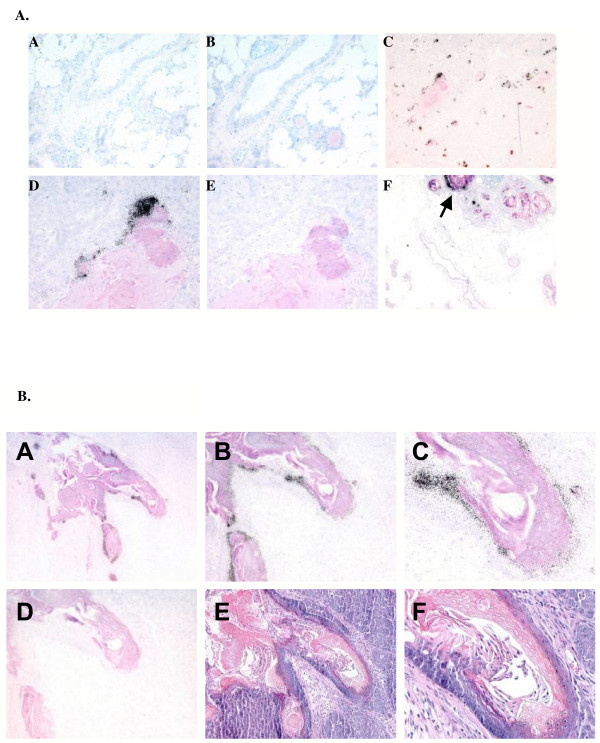
A Strong focal expression of mouse S100A7/psoriasin RNA in mammary gland tumors compared to little expression in matched normal mammary gland tissue using in situ hybridization Sections from formalin fixed paraffin-embedded mammary tissue samples matched to the frozen tissue from which RNA was previously isolated for RT-PCR analysis were used for in situ hybridization analysis of mouse S100A7/psoriasin expression: A, C, D, F show hybridization with mouse S100A7/psoriasin 35S-labeled antisense cRNA; B, E show hybridization with mouse S100A7/psoriasin 35S-labeled sense cRNA. A = high magnification (400X) section of normal mammary gland, hybridized with mouse S100A7/psoriasin 35S-labeled antisense cRNA. B = high magnification (400X) adjacent section to A hybridized with mouse S100A7/psoriasin 35S-labeled sense cRNA. C = low magnification (100X) of section from the matched DMBA mammary tumor from same animal shown in A hybridized with mouse S100A7/psoriasin 35S-labeled antisense cRNA. D = higher magnification (400X) of C. E = high magnification (400X) of adjacent section from the same mammary tumor shown in D, hybridized with mouse S100A7/psoriasin 35S-labeled sense cRNA. F = low magnification (100X) of a single tissue section (tissue from a different mouse to that shown in A-E)) hybridized with mouse S100A7/psoriasin 35S-labeled antisense cRNA, where strong focal expression of mouse S100A7/psoriasin RNA is observed in the mammary gland tumor (black arrow) with little or no expression in the surrounding normal mammary gland tissue. B Localization of mouse S100A7/psoriasin expression to areas of squamous differentiation in DMBA-induced mammary gland tumors Sections from formalin fixed paraffin-embedded DMBA-induced mammary tumor samples matched to the frozen tissue from which RNA was previously isolated for RT-PCR analysis were used for in situ hybridization analysis of mouse S100A7/psoriasin expression. A = low magnification (100X) of tumor section hybridized with mouse S100A7/psoriasin 35S-labeled antisense cRNA. B = higher magnification of A (200X), C = high magnification of B. D = adjacent section to that seen in A, B, C, and at same magnification as B but hybridized with mouse S100A7/psoriasin 35S-labeled sense cRNA. E and F are haematoxylin and eosin stains of adjacent sections to that shown in A, B, C, and D. E is the same magnification as in B, and F is the same magnification as that shown in C. Squamous differentiation in the haematoxylin and eosin stained adjacent sections is visualized as a characteristic "pearling" pattern where epithelial tumor cells (purple) differentiate into keratinocytes (pink) before denucleating and sloughing off into the inner lumen (white). Thus cells on the outer margin of the pearled area are undergoing squamous differentiation, and those correspond to cells expressing mouse S100A7/psoriasin RNA, in A, B, and C.